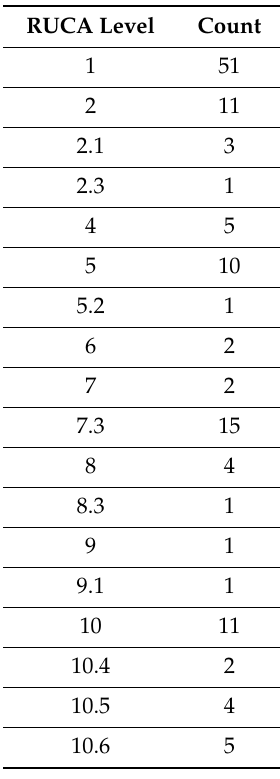
Figure 2. Depiction of study subjects based on Rural-Urban Commuting Codes RUCA zip codes. All individuals located in West Virginia, Ohio, or Kentucky. Table 1. Rural-Urban Commuting Area Codes (RUCA) Distribution for the States of WV, KY, and OH.